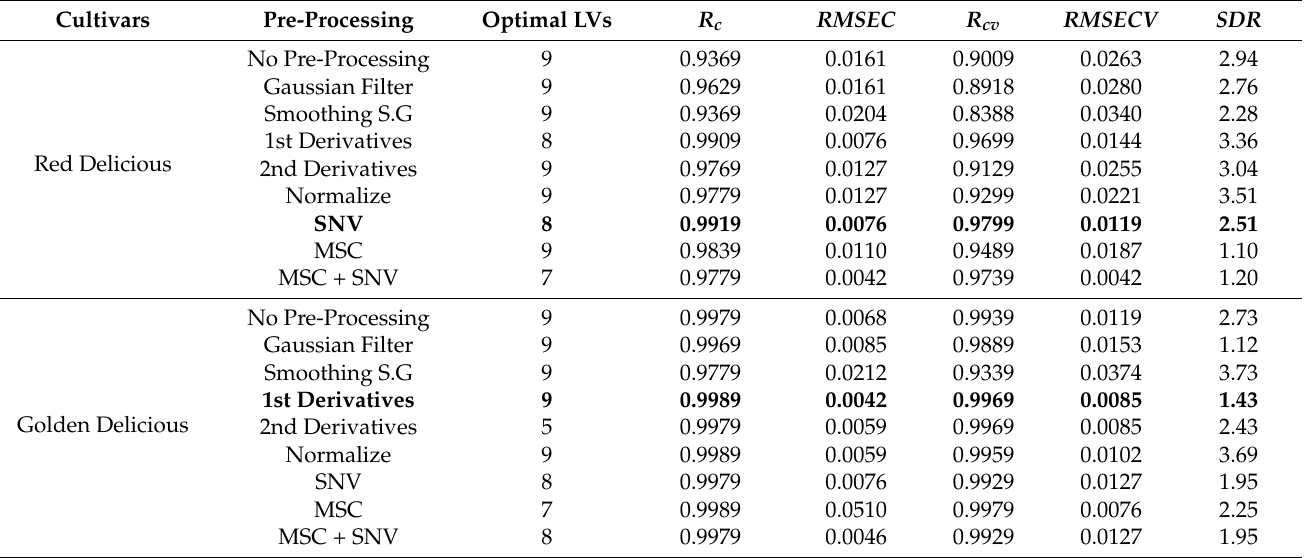
Table 3. Validation results of PLS models, based on different hyperspectral imaging pre-processing methods for pH of Red Delicious and Golden Delicious